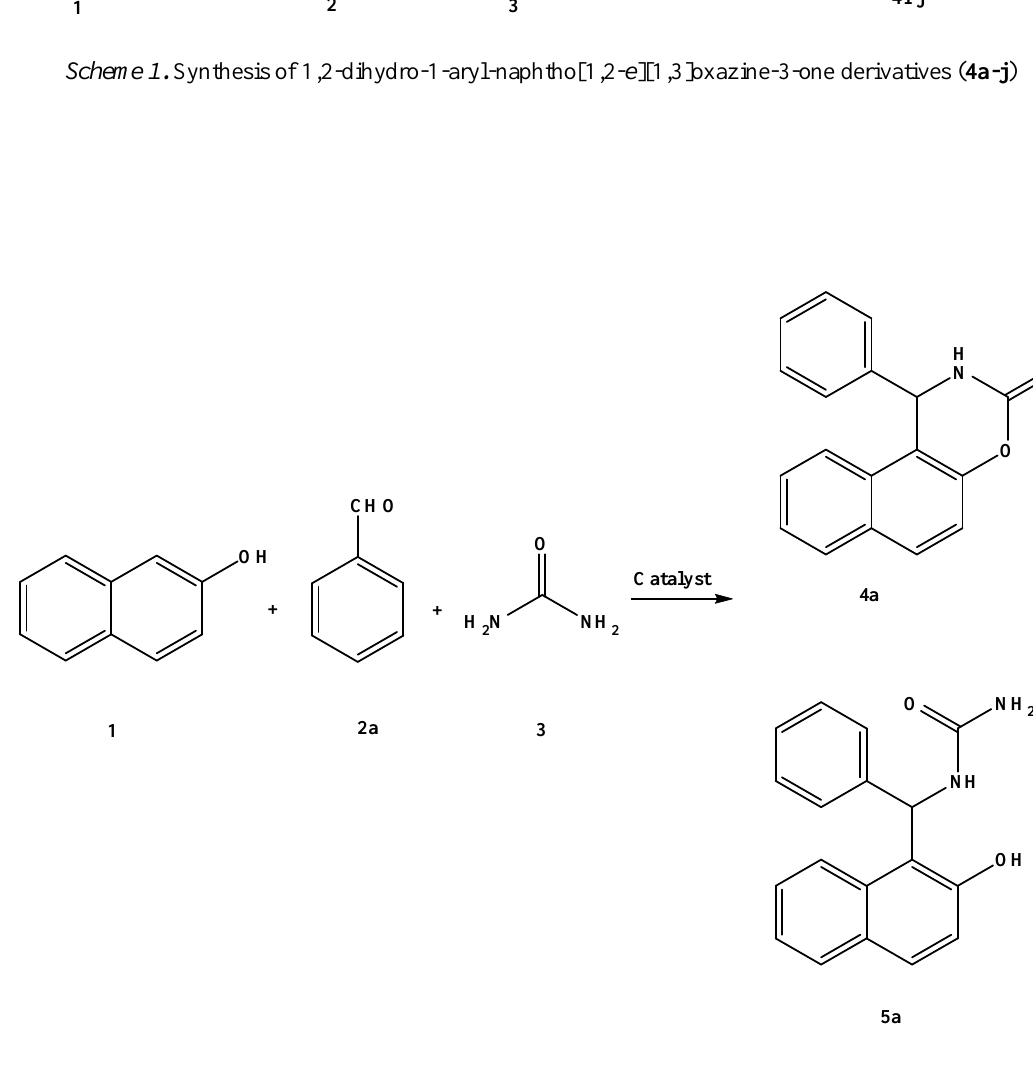
Scheme 2. Possible cyclized and uncyclized products of the